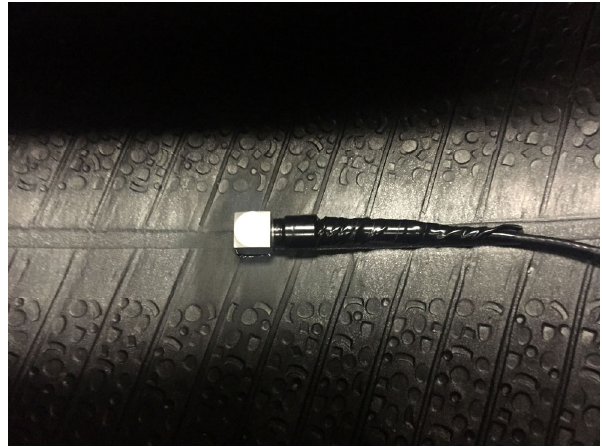
Fig. 5 Using tread sensors (tri-axial accelerometer) to estimate the friction. Reproduce with permission from Ref. [40]. Copyright Khaleghian,